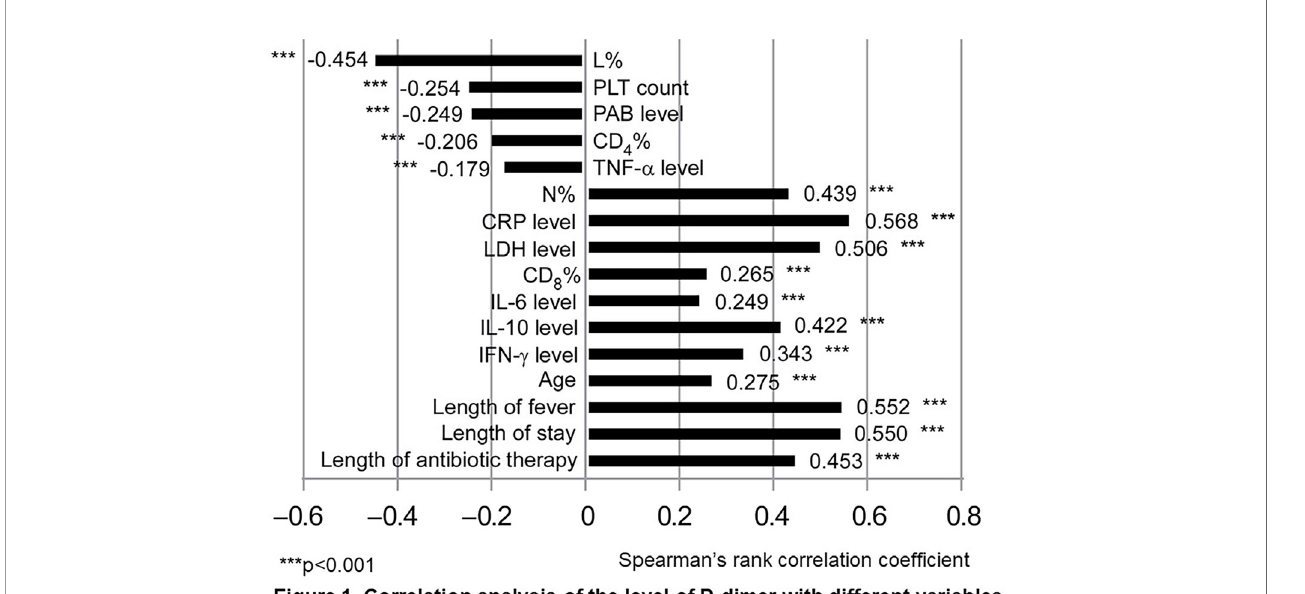
FIGURE 1 | Correlation analysis of the level of D-dimer with different variables. Spearman rank-correlation coef fi cients were used to describe the association between different variables and D-dimer. Statistical signi fi cance was de fi ned as P < 0.05, ***P < 0.001. N, neutrophil; L, lymphocyte; PLT, Platelet; CRP, C-reactive protein; LDH, Lactate dehydrogenase; PAB, Prealbumin; IL-6, Interleukin 6; IL-10, Interleukin 10; TNF- a , Tumor necrosis factor-alpha; IFN- g ,